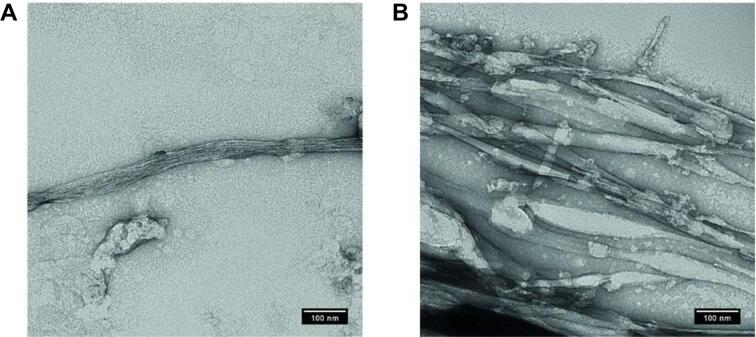
Transmission electron micrographs of fibrillar material formed by (A) PIIGIPIQDL, a peptide derived from the C4-C5 region of RodA and (B) SLIGL, a peptide with predicted amyloidogenic sequence from the C7-C8 region.